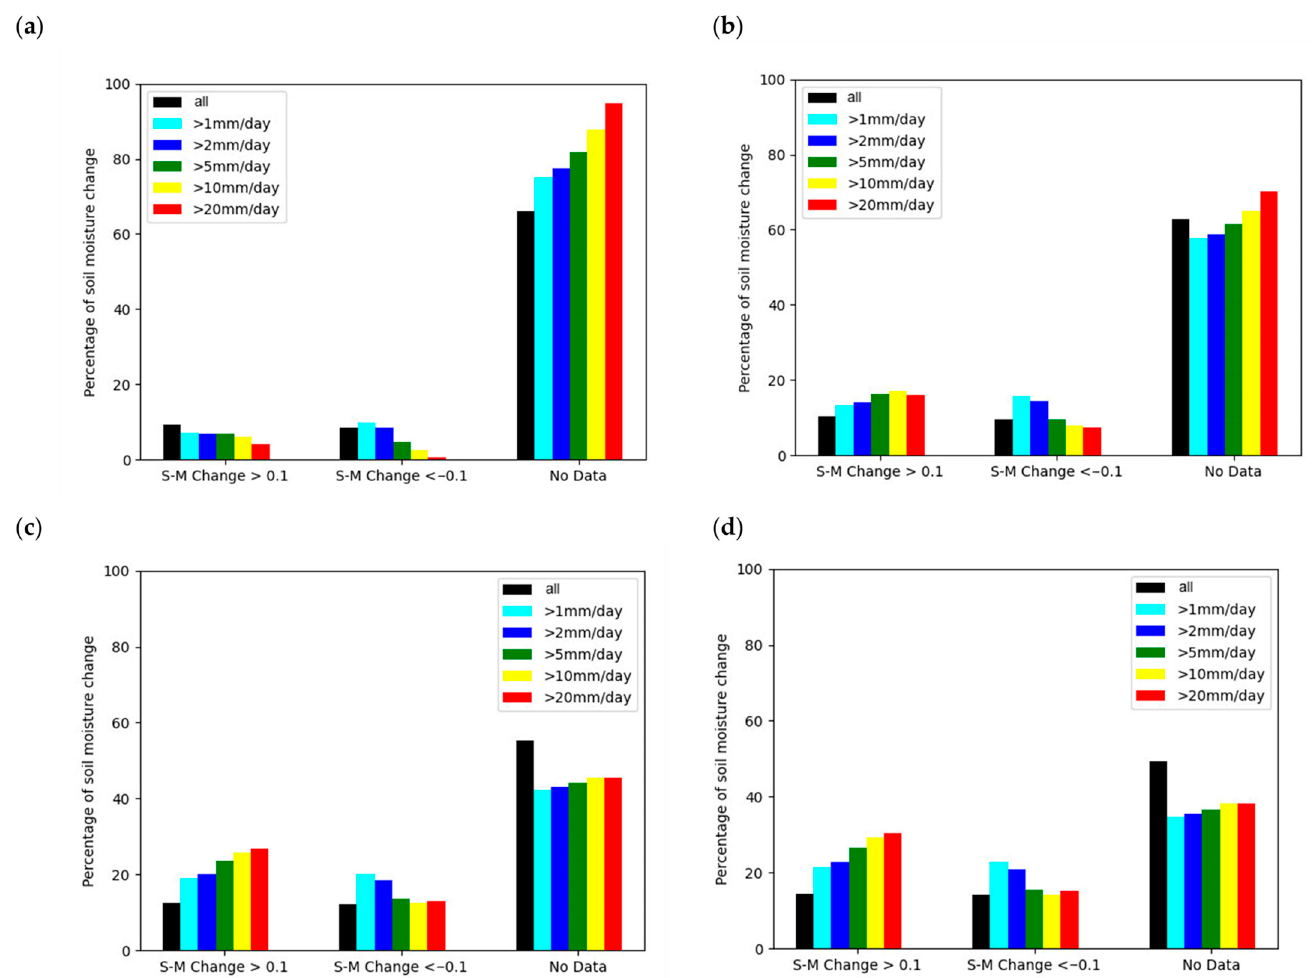
Figure 7. Change of relative soil moisture for different precipitation sums. As a reference, the total percentage of pixels that falls into the three relative soil moisture change categories irrespective of the precipitation is also given as ‘all’. ( a ): The soil moisture change was calculated from consecutive days. ( b ): The soil moisture change was calculated allowing gaps of up to four days but uniform for the entire domain. ( c ): The soil moisture change was calculated allowing gaps of up to four days individually for every pixel. ( d ): Same as lower left, but a reverse speckle filter interpolating gaps of up to 100 pixels was applied to the data.